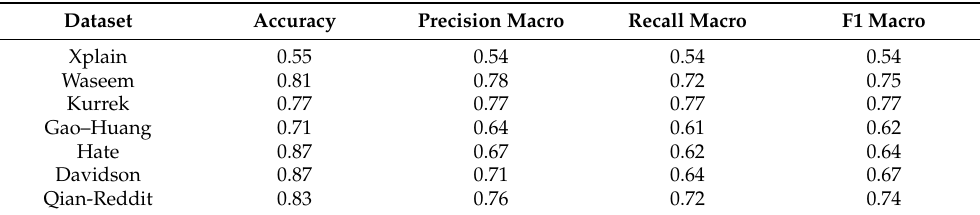
Table A6. Scores obtained on the benchmark Datasets using the convolutional neural network model. The embeddings were made with the help of GloVe vectors.